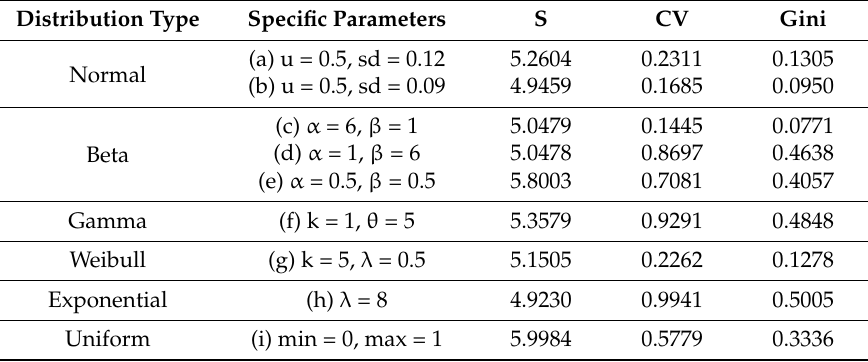
Table 2. Calculation results of the three methods for the simulated data in Scheme